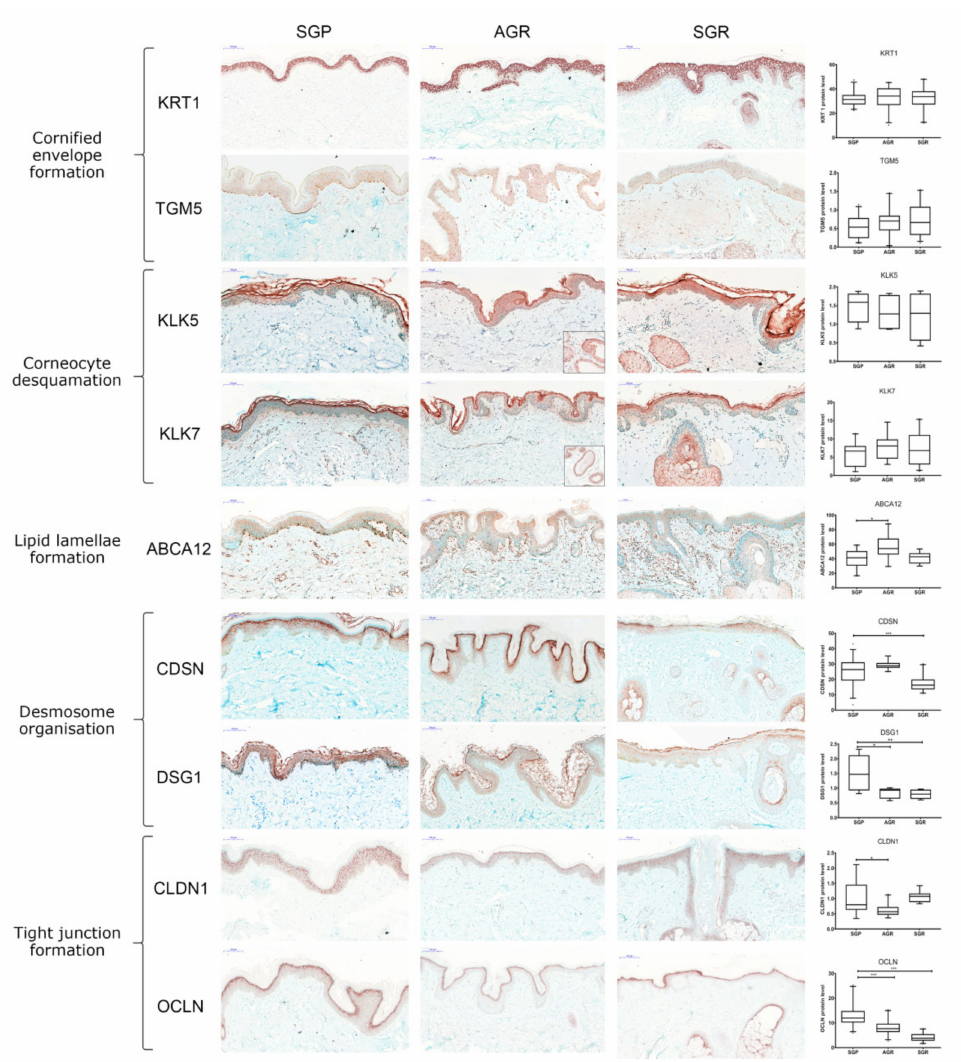
Figure 2. Prominently weakened cell junction components characterize SGR and AGR skin regions compared with GP areas under steady-state. Representative images for immunostaining and quantifi- cation of epidermal levels of KRT1, TGM5, CDSN, DSG1, CLDN1, OCLN, ABCA12, KLK5, and KLK7 in healthy GP, AGR, and SGR skin sections. Bar = 100 µ m. Means ± 95% confidence intervals for pro- tein levels are shown. (* p < 0.05, ** p < 0.01, *** p < 0.001, determined by one-way ANOVA followed by Sidac post hoc test) Abbreviations: ABCA12, ABC transporter 12B; AGR, apocrine gland-rich; CDSN, corneodesmosin; CLDN, claudin; DSG1, desmoglein 1; GP, gland-poor; KLK, kallikrein-related peptidase; KRT, keratin; OCLN, occludin; SGR, sebaceous gland-rich; TGM,